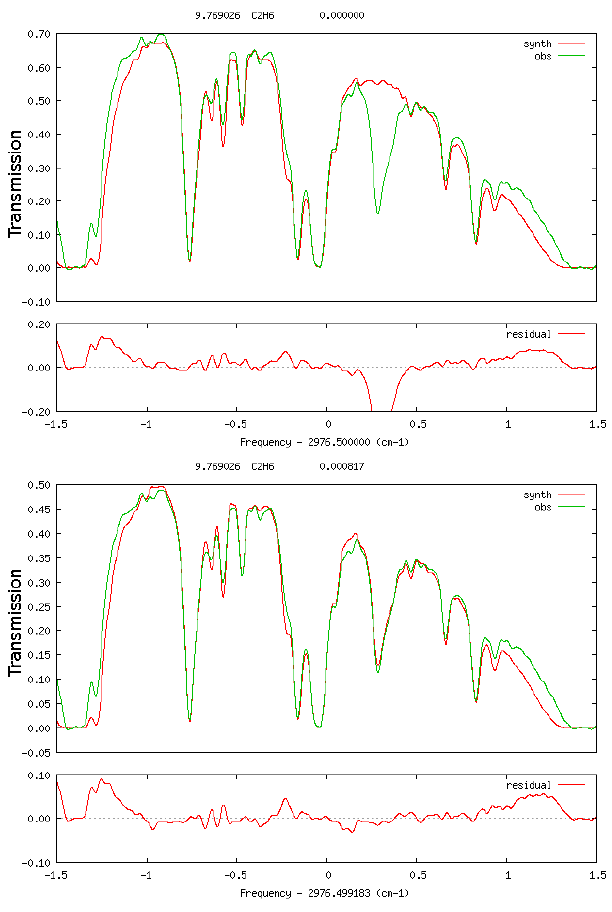
Fig. 1. Calculated spectrum, observed spectrum and residuals for occultation ss11613 at 9.76km. Top panel shows a calculated spec- trum without the C 2 H 6 contribution. In the residual plot we can ob- serve the feature due to the absence of C 2 H 6 in the forward model.